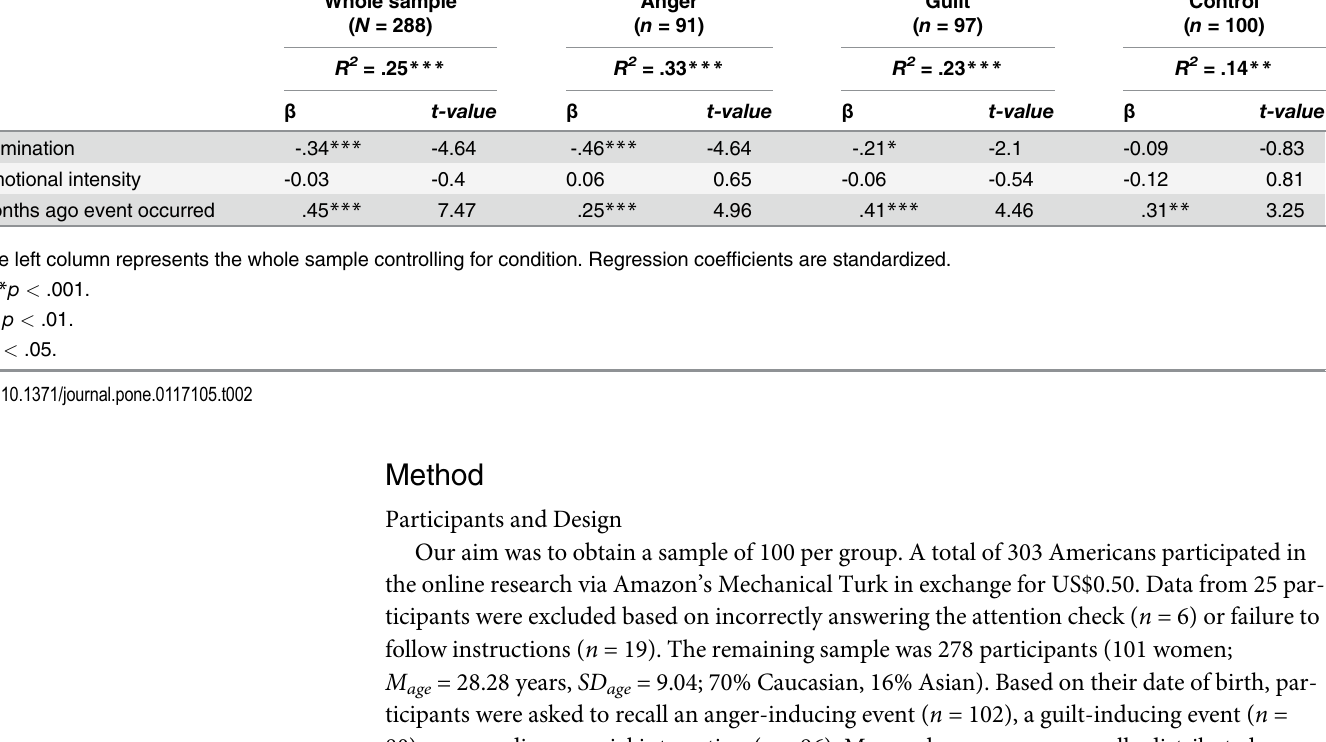
Table 2. Regression analyses from Study 1 predicting temporal psychological distance.